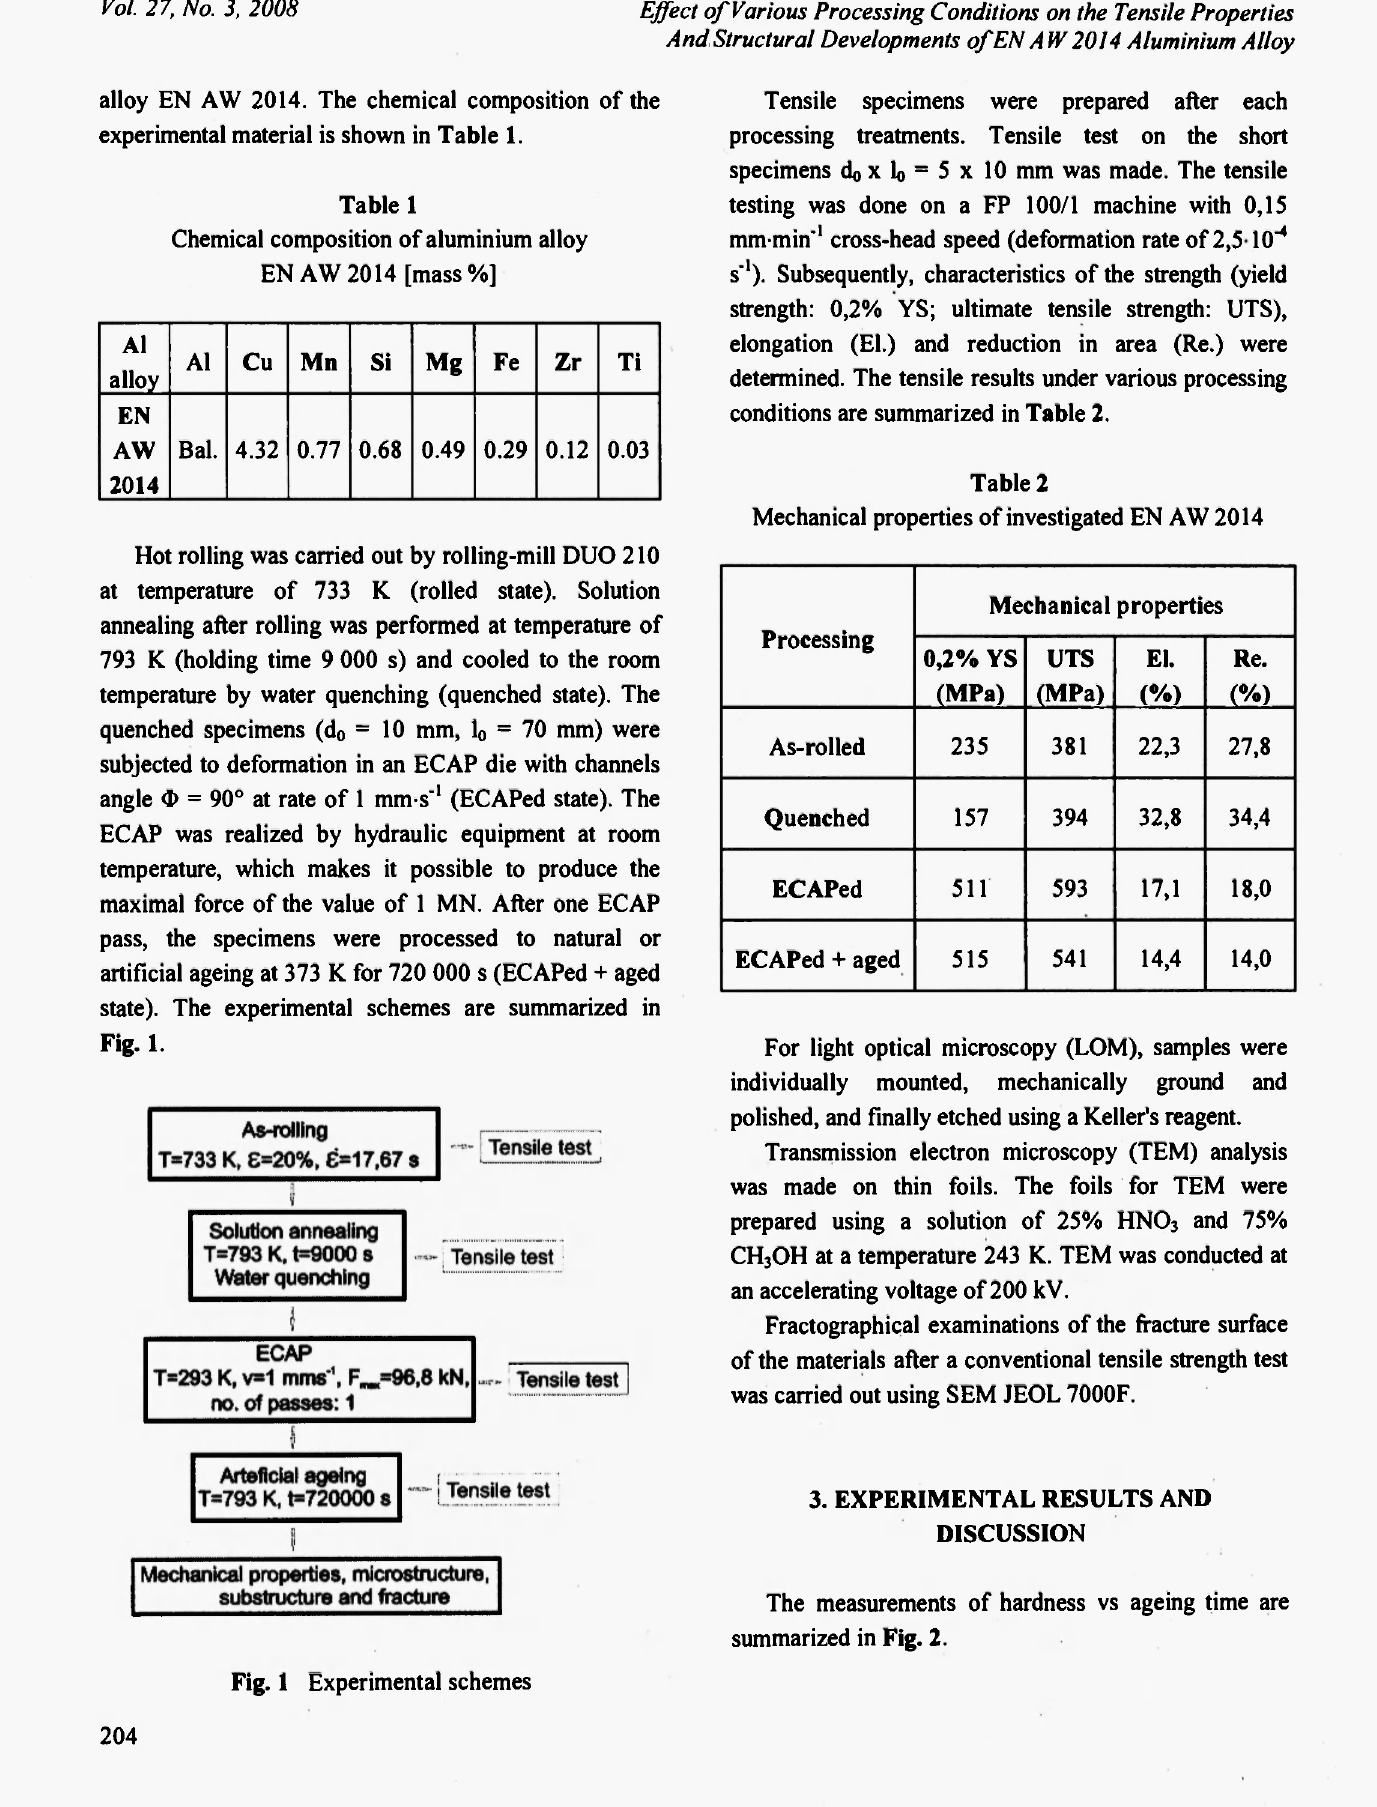
processing treatments. Tensile test on the